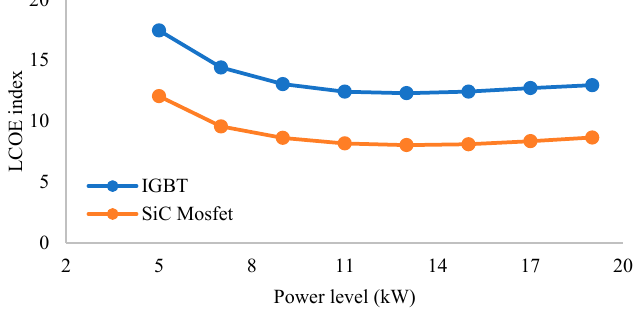
Figure 21. LCOE index Si vs. SiC (Tehran).